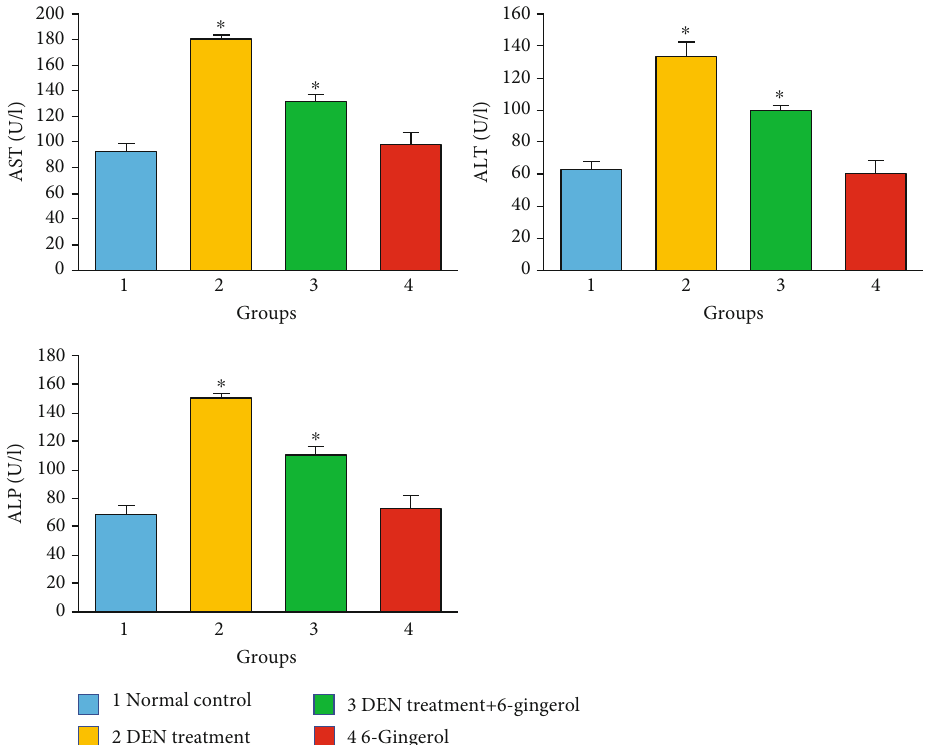
Figure 5: The role of 6-gingerol on liver function enzymes. ALT, ALP, and AST enzyme levels were considerably higher in the group of DEN- induced rats than in the control group. However, the group that got both DEN and 6-gingerol demonstrated substantially lower ALP, ALT, and AST levels than the DEN-induced group only. Statistical signi fi cances are compared between the normal control vs. DEN-induced groups only ( p < 0 : 01 ), and DEN-induced versus both DEN- and 6-gingerol-treated groups ( p < 0 : 05 ).